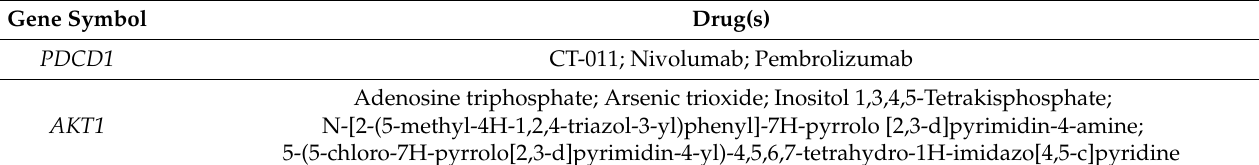
Table 1. Complete list of highly correlated drug targets among the 27 common